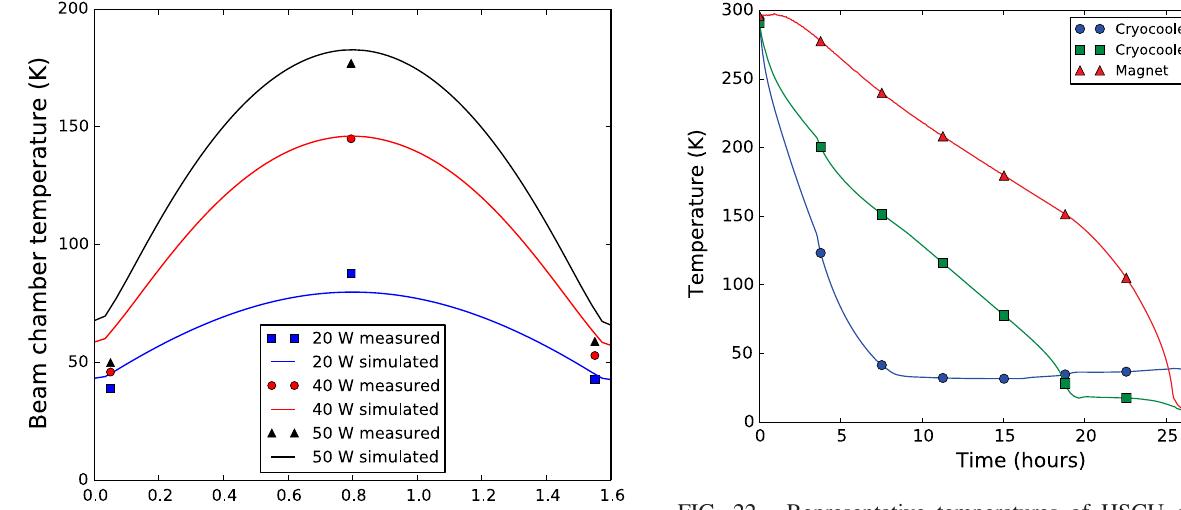
FIG. 22. Representative temperatures of HSCU components during the cool down process. The magnet temperatures reach 6 K after 36 h which enables the transfer of LHe to bring the temperatures to the operating value of 4.2 K.